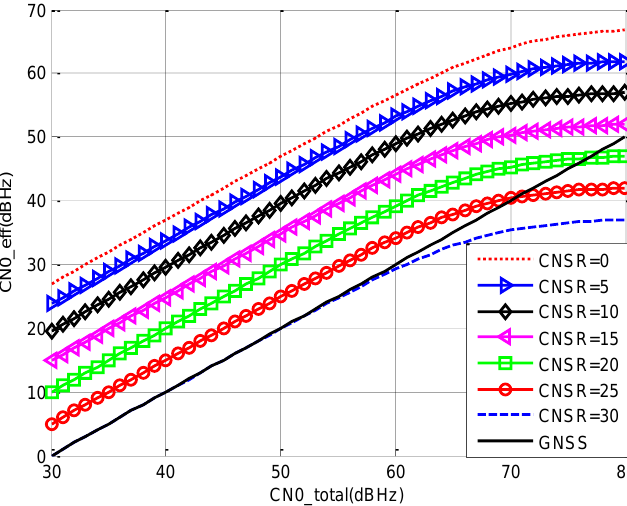
CN under different CNSR . Figure 6. The CN0 ef f versus CN 0 total under di ff erent CNSR versus 0 t o t a l eff